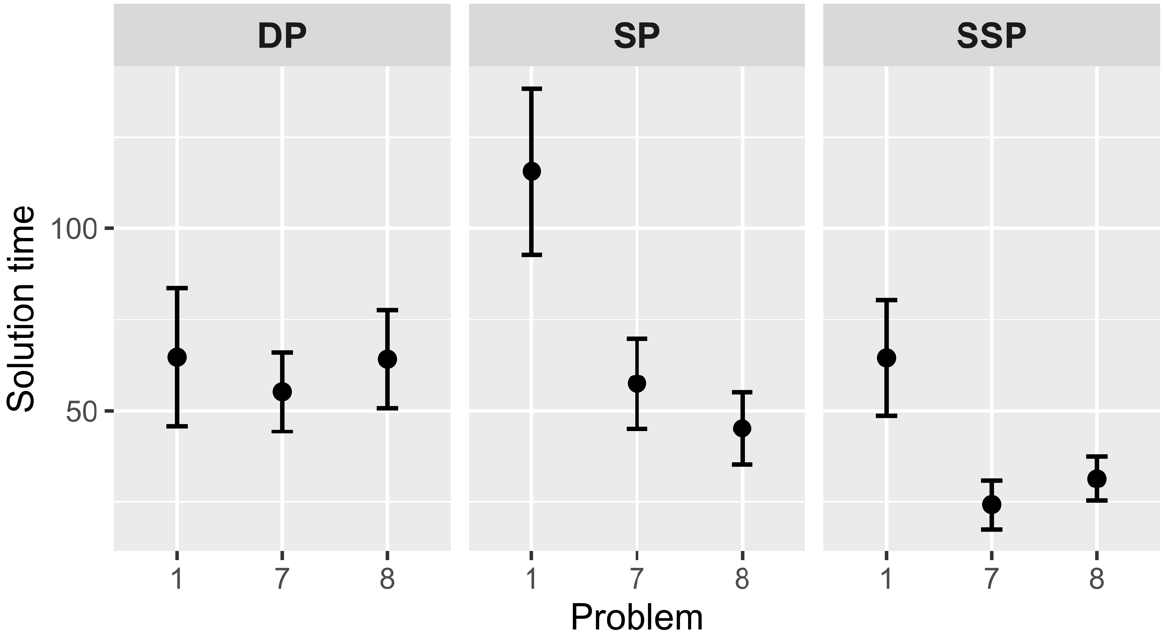
Figure 4. Solution times of different groups. Note. Vertical bars denote standard errors. DP—different principle group, SP—same principle group, SSP—same structure and principle group.